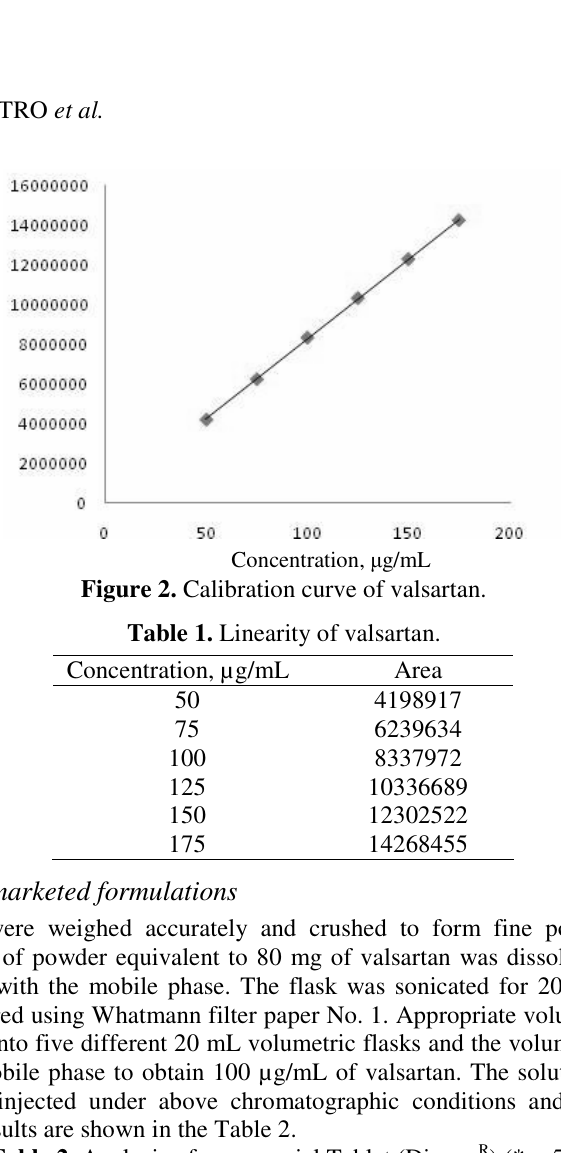
Table 2. Analysis of commercial Tablet (Diovan R )